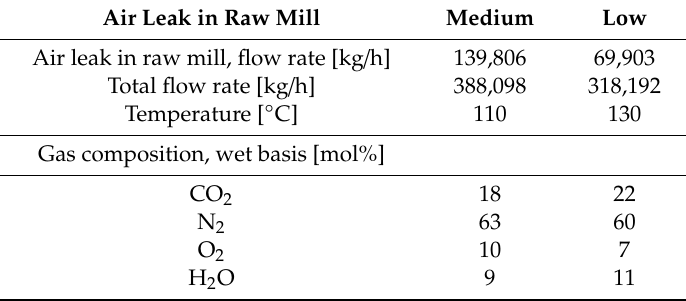
Table 1. Gas parameters at the stack